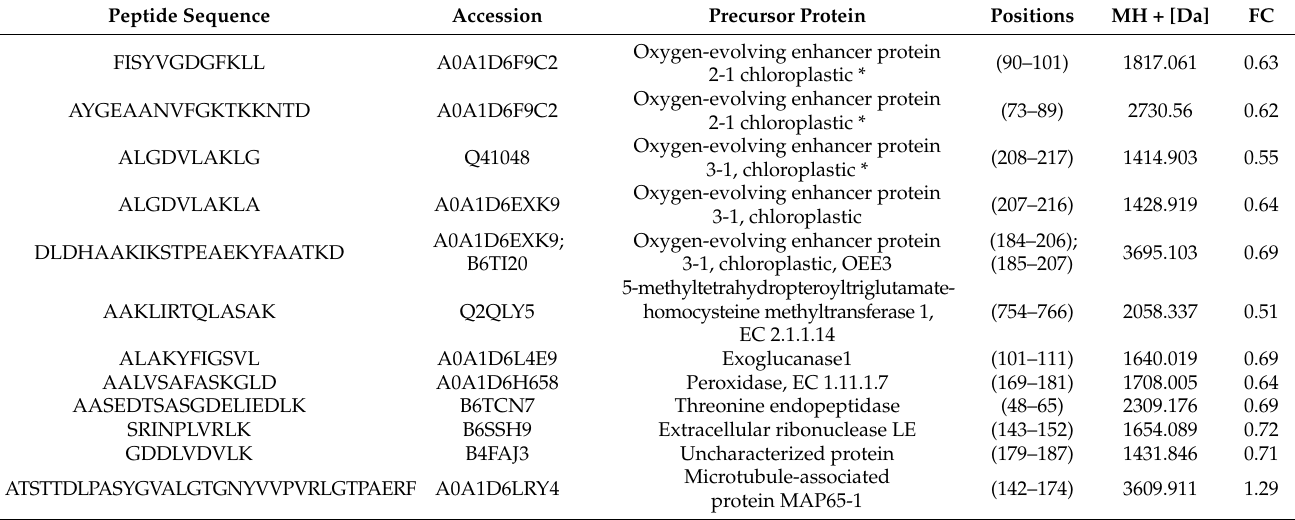
Figure 6. ( a ) Scatter plot of molecular weight (Mw) versus isoelectric point (pI) distribution of common differentially expressed peptides (DEPs); ( b ) histogram showing the cleavage sites of N-terminal and C-terminal amino acid of the preceding and identified peptides; and ( c ) prediction of the secondary structure of precursor protein (B6SSH9) of peptides. Table 3. Twenty common DEPs found in maize leaves on day 5 after infection with Bipolaris maydis